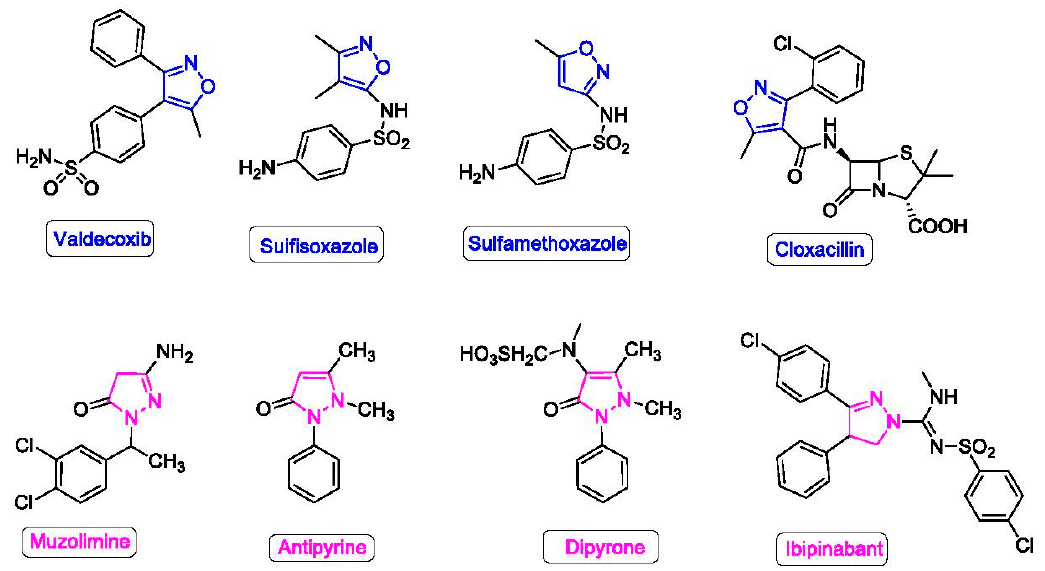
Figure 1. Structures of some clinically useful drugs containing isoxazole and dihydropyrazole